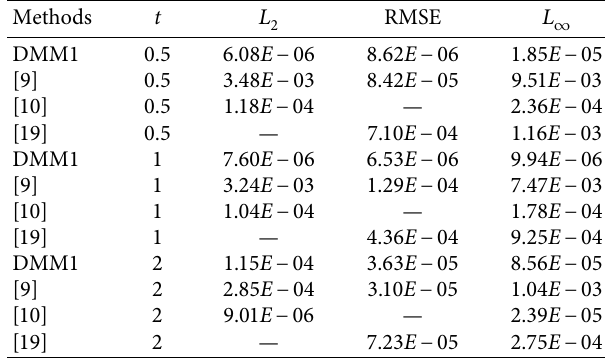
Table 2: Numerical results for Example 2.